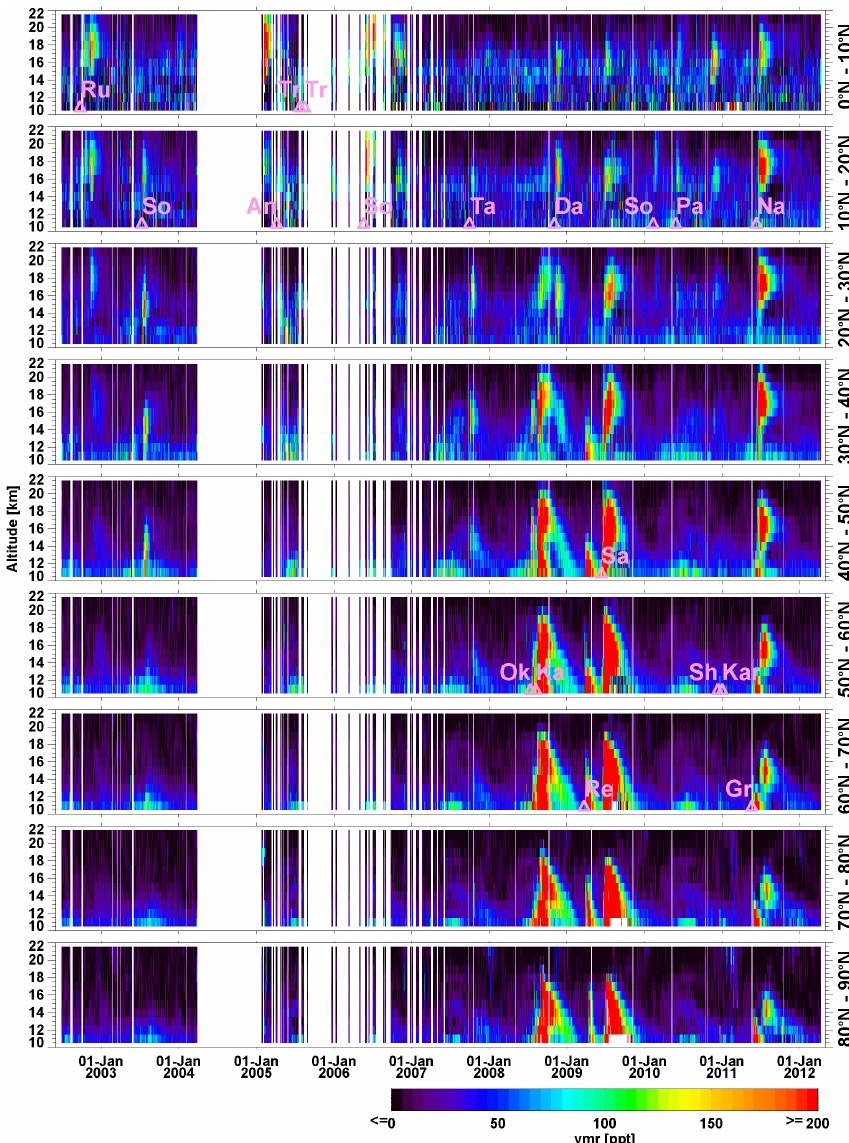
Figure 12. Same as Fig. 11 but for the Northern